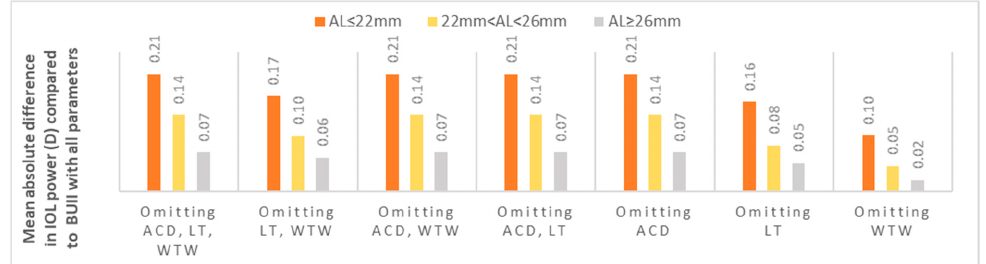
Figure 2. The mean absolute difference in IOL power calculation between partial biometry data and all BUII parameters stratified by axial length. ACD; anterior chamber depth, D; diopters, IOL; intraocular, LT; lens thickness, WTW; white-to- white.